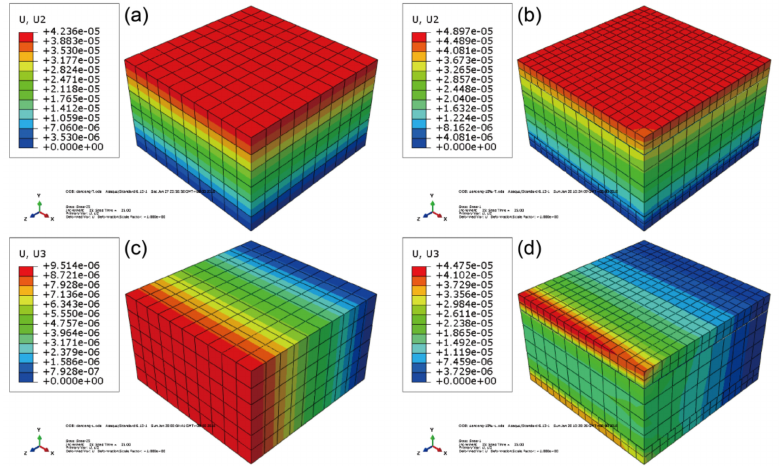
Figure 6. Simulated thermal expansion strain of the cut Co-WPCs in the thickness direction: ( a ) single core layer and ( b ) Co-WPCs (S0); in the extrusion directions: ( c ) single core layer and ( d ) Co-WPCs (S0).